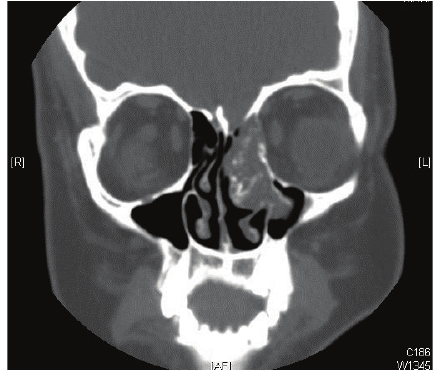
Figure 2: CT sinus demonstrating indolent mass with stippled calcifications centered at left middle turbinate.